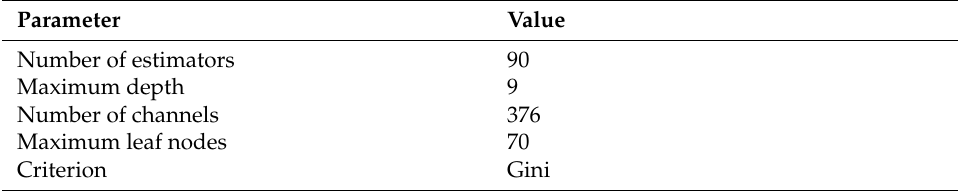
Table 5. Overview of the RF model training